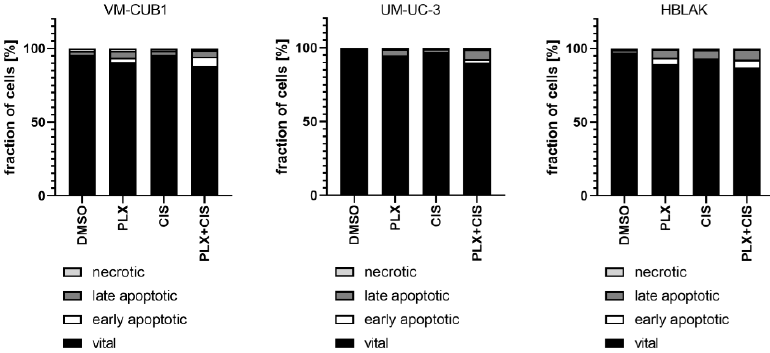
Figure 6. Induction of cell death after combination treatment with PLX and cisplatin at a reduced dosage. Induction of cell death was measured by annexin V/ PI staining and flow cytometry 72